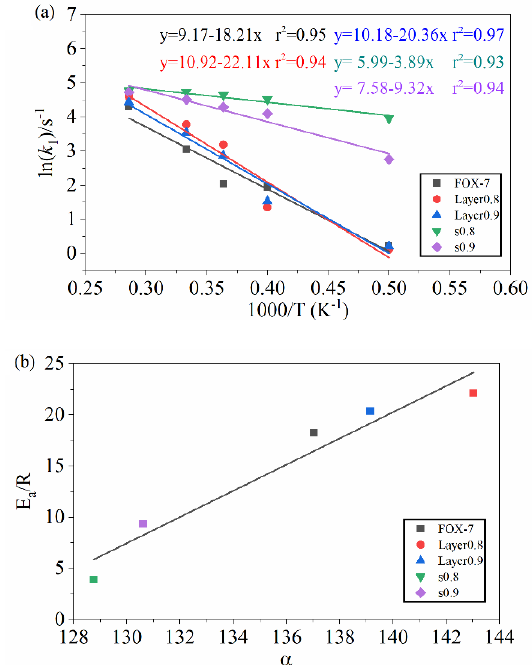
Figure 6. ( a ) Logarithm of FOX − 7 decomposition rate constant ln(k) against (1/T) in range of 2000–3500 K. The solid point and solid line represent calculated and linearly fitted values. ( b ) The correlation between the ( α ) and E a R